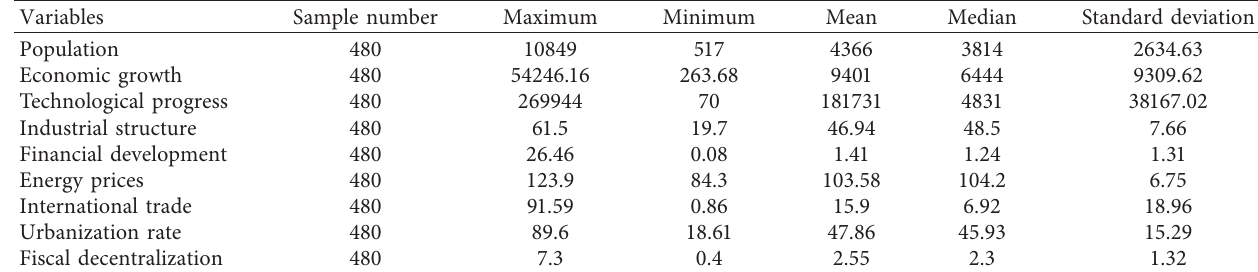
Table 1: Descriptive statistical results of carbon emission impact factors in China.